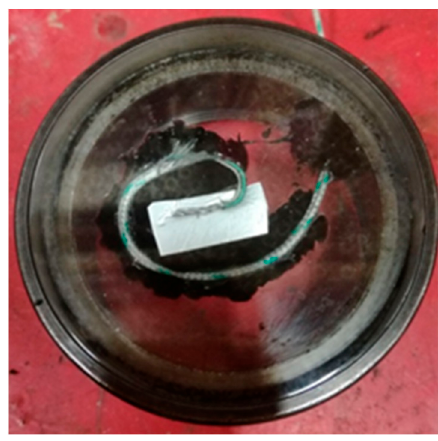
sion from Ref. [17] Copyright 2019 SAE International.